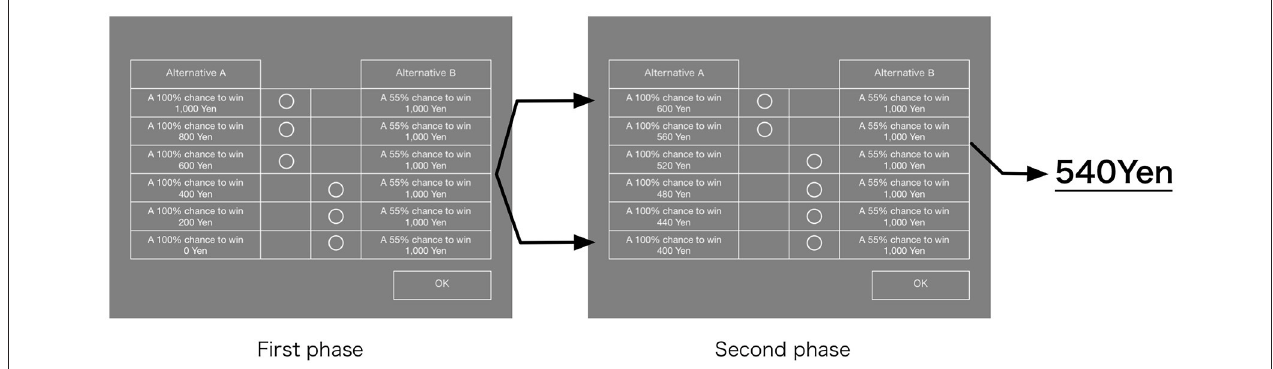
FIGURE 2 | Experimental screens and task process.